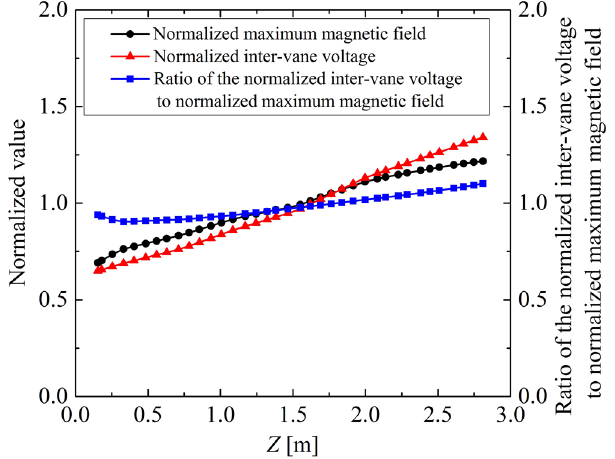
FIG. 13. Designed normalized maximum magnetic field, de- signed normalized inter-vane voltage distribution, and the ratio between the two variables for the XiPAF RFQ. Both the magnetic field and voltage are normalized by the corresponding RMS (root-mean-square) values over the longitudinal position Z .